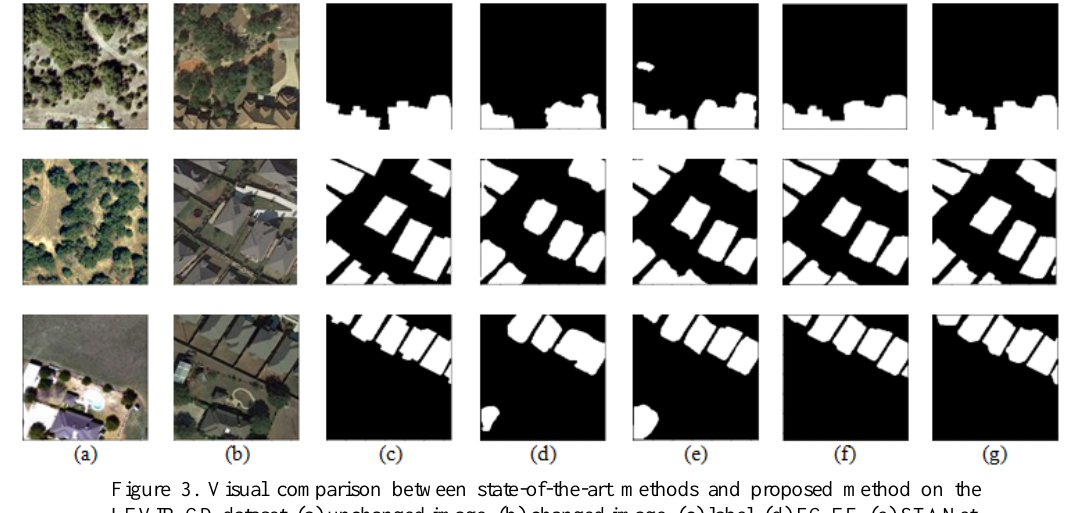
Figure 3. Visual comparison between state-of-the-art methods and proposed method on the LEVIR-CD dataset. (a) unchanged image, (b) changed image, (c) label, (d) FC-EF, (e) STANet, (g) AGCDetNet , i: proposed method.